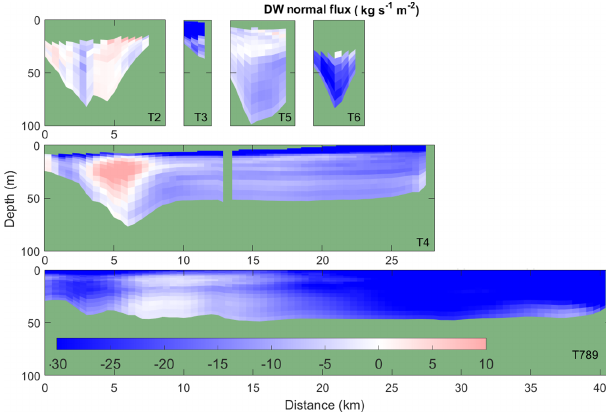
Figure 15. As in Fig. 13, but for dense-water mass fluxes. Green areas denote the bathymetry and model cells where no dense water is modelled. T1 is omitted from the figure, as almost no dense-water transport occurred